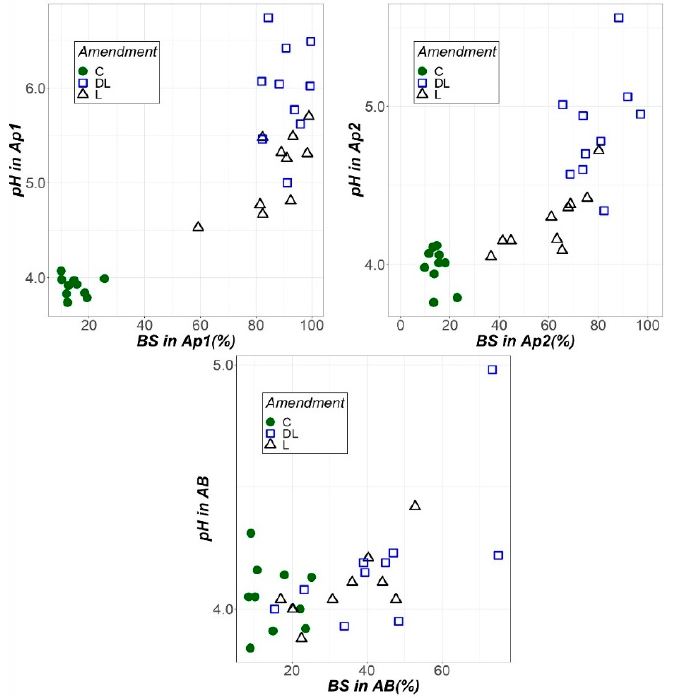
Figure 8. Soil pH and base saturation (BS) as a function of the liming treatment (control (C), dolomitic limestone (DL) and limestone (L)).